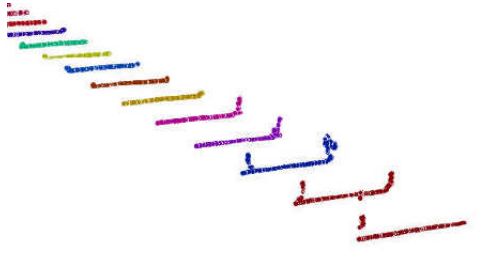
Figure 1. Extraction of 3D point